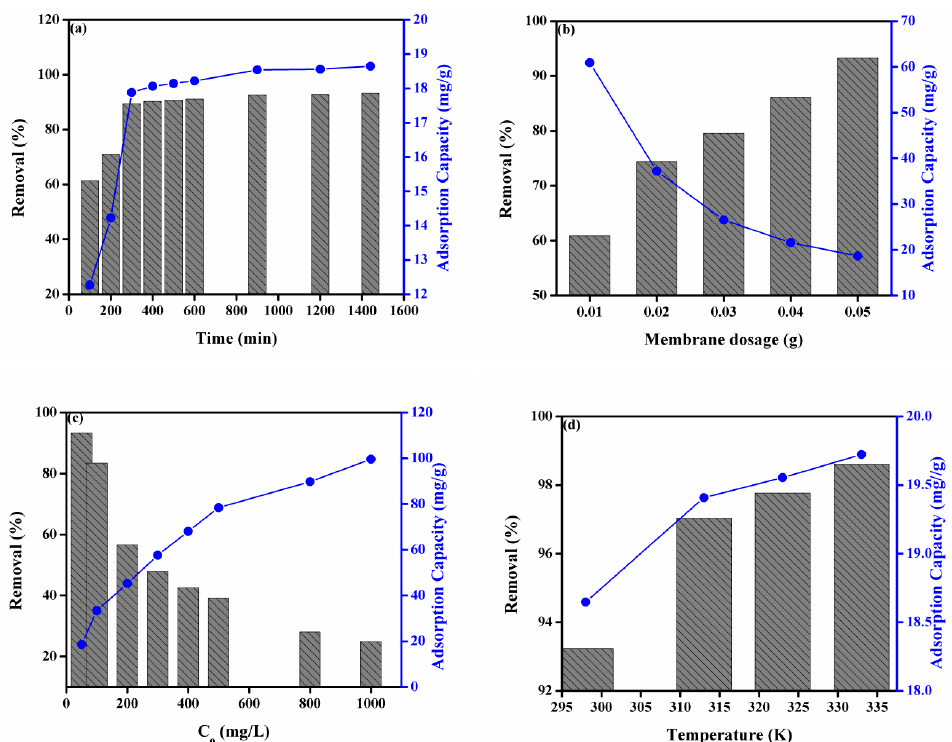
Figure 2. ( a ) Effect of contact time, ( b ) membrane dosage (adsorbent), ( c ) initial concentration of aqueous dye solution, ( d ) temperature on the percentage discharge of MO from aqueous solution and adsorption capacity.